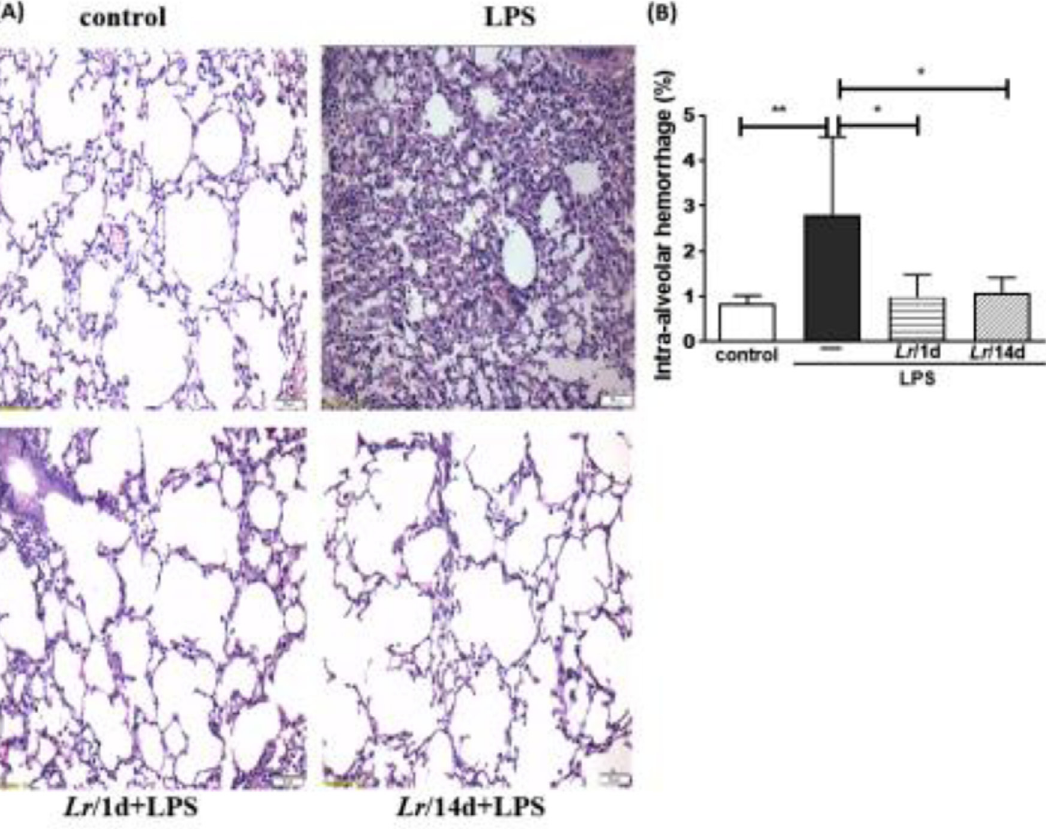
Fig. 8. Lung morphometry (200 × ). The C57Bl/6 mice were treated with Lacticaseibacillus rhamnosus (10 9 CFU Lr in 300 µ L of PBS, orogastric by gavage) for 14 days or one day, before E. coli LPS instillation (0.5 mg/Kg, intranasal). The mice were euthanized 24 h after the LPS. The histological sections were stained with H & E and the photomicroscopy of the parenchyma was performed using a microscope (OLYMPUS MODEL BX43F) and analyzed using the IMAGE PRO PLUS program. Photomicro- scopy (magni fi cation: 200 × ) (8A); haemorrhage (8B). The results are expressed as mean ± SEM **** p < 0.0001; *** p < 0.001; ** p < 0.01; * p < 0.05 and ns: non-signi fi - cant